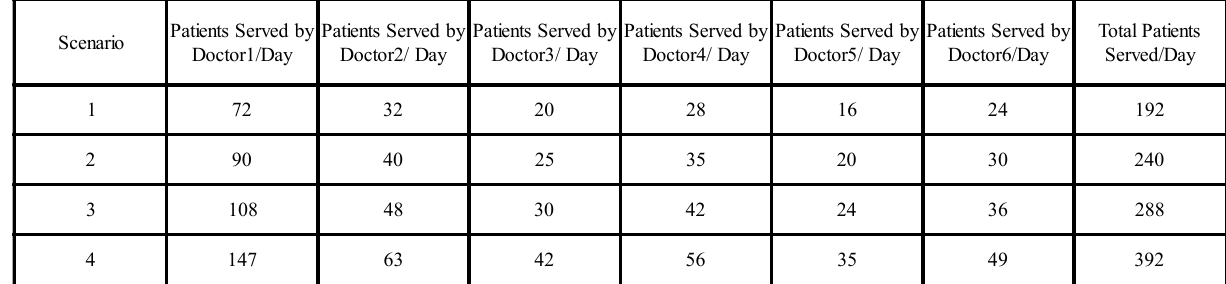
TABLE 9. PATIENTS SERVED BY EACH DOCTOR PER HOUR AT THE OPD